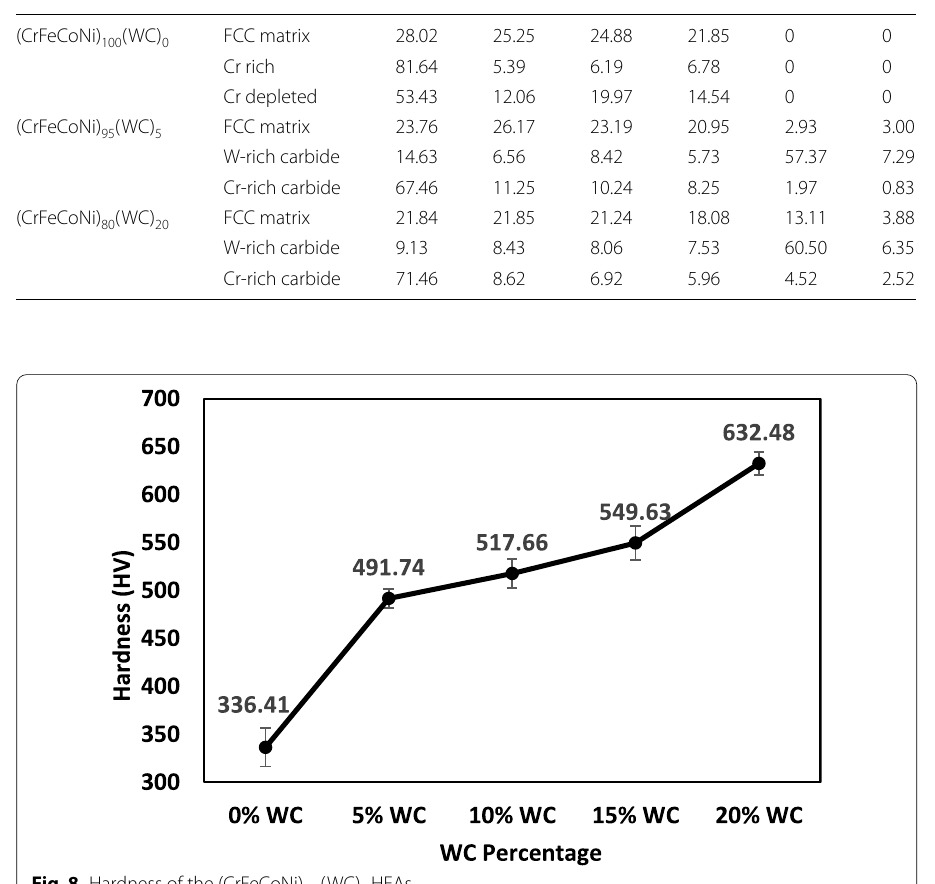
Fig. 8 Hardness of the (CrFeCoNi) 1-x (WC) x